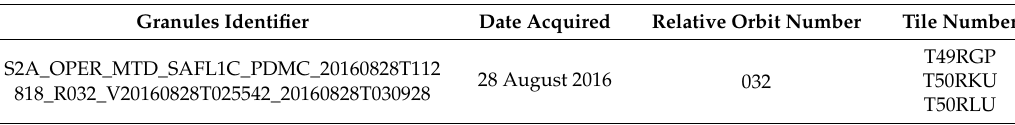
Table 2. Description of the multi-spectral Sentinel-2 images.